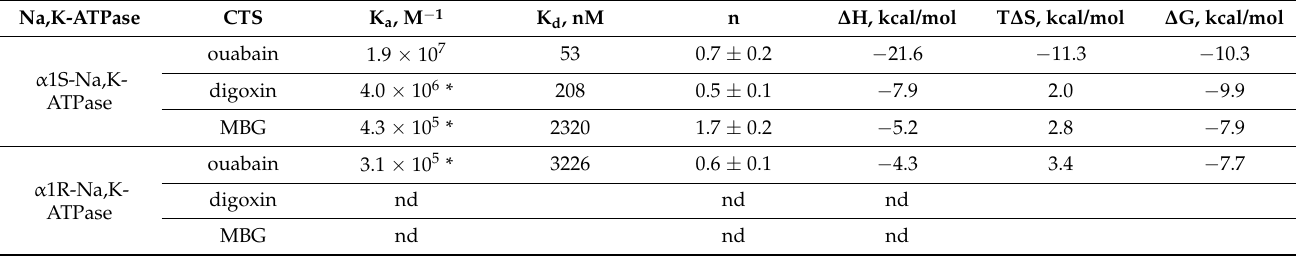
Table 1. Thermodynamic parameters of α 1S- and α 1R-Na,K-ATPase in E2P-conformation binding to ouabain, digoxin and marinobufagenin (MBG) at pH 7.4 and 37 ◦